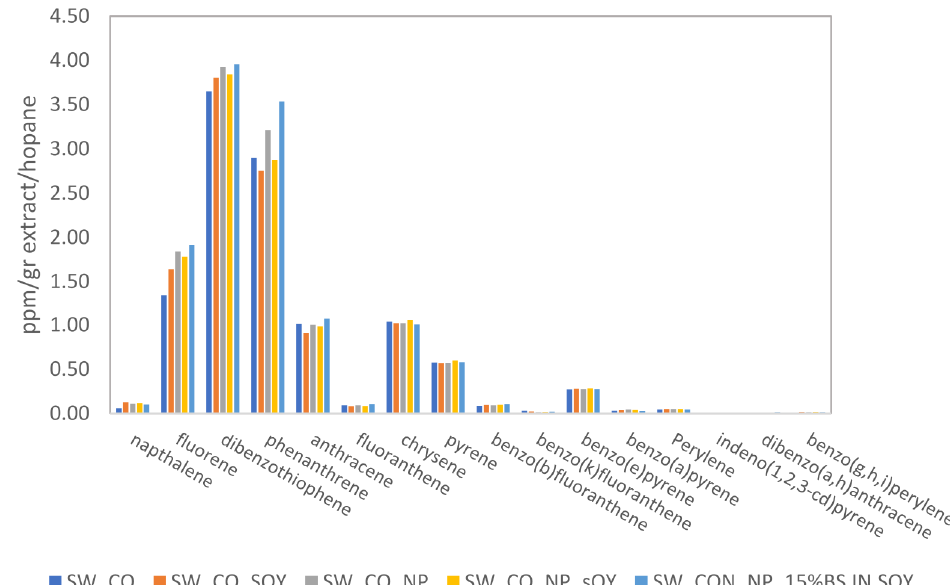
Figure A6. Bioremediation test results. Aromatic hydrocarbons concentration after 7 days of bioremediation. (a) SW_CO: Sea water with crude oil. (b) SW_CO_SOY: Sea water, crude oil and soybean oil. (c) SW_CO_NP: Sea water, crude oil and N and P nutrients (d) SW_CO_NP_SOY: Sea water, crude oil, N and P nutrients and soybean oil. (e) SW_CO_NP_15%BS.IN.SOY: Sea water, crude oil, N and P nutrients and BS-in-SOY agent 15% w/v.